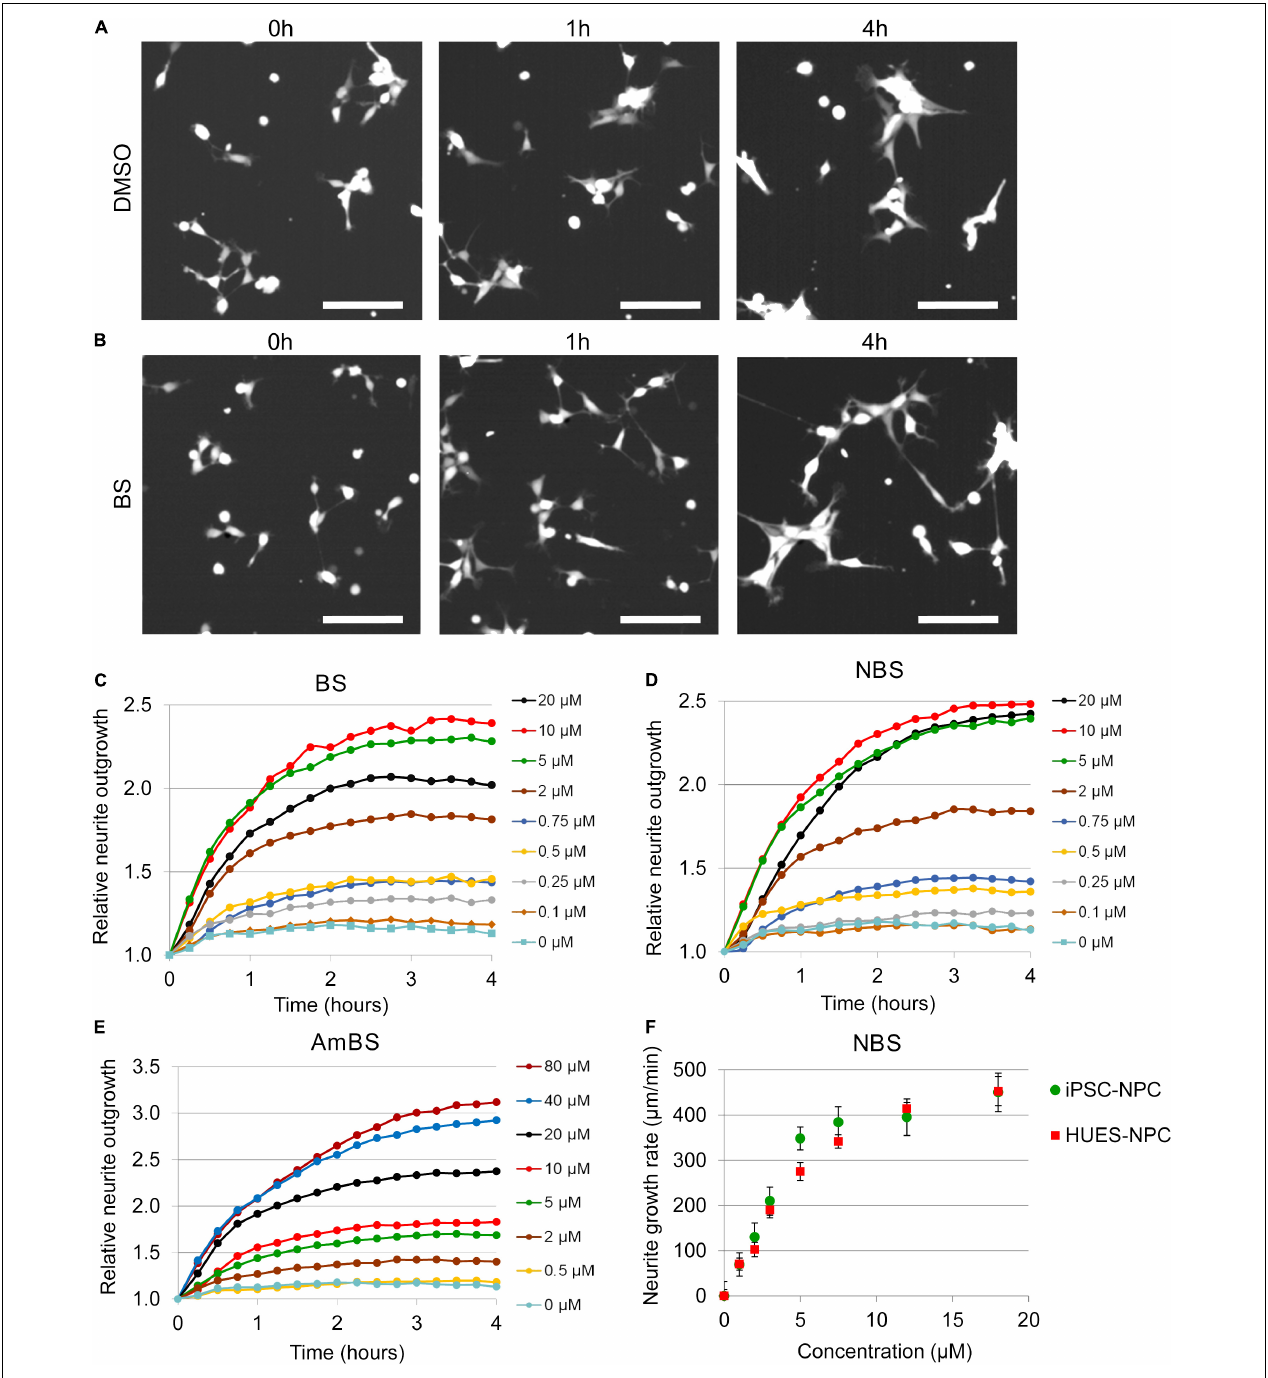
FIGURE 2 | Effect of blebbistatin and blebbistatin derivatives on the neurite outgrowth of NPCs. (A,B) Representative images of NPCs stably expressing eGFP treated with vehicle (DMSO) or 10 µ M blebbistatin (BS). Time points indicate elapsed time after treatment. (C–E) Kinetics of neurite growth in eGFP-NPCs subjected to BS, para-nitroblebbistatin (NBS), or para-aminoblebbistatin (AmBS) in the indicated concentrations. The total lengths of neurites were determined in six fields of view containing 120–150 cells in each condition. The neurite lengths were normalized to the initial values. All three compounds stimulated neurite outgrowth in a dose dependent manner. The EC 50 values for BS and NBS were about 2 µ M, whereas EC 50 value for AmBS was above 10 µ M. Panels (C–E) depict representative experiments. (F) Dose-response curves for NBS-stimulated neurite outgrowth analyzed in two human NPCs of different origin, i.e., iPSC-derived neural progenitor cells (iPSC-NPC) and NPCs differentiated from the human embryonic stem cell line HUES9 (HUES-NPC). Both NPC lines stably expressed eGFP. The neurite outgrowth rates were determined from the initial growth rates. The mean ± SEM values from three independent experiments are shown. No marked difference was observed between the two cell